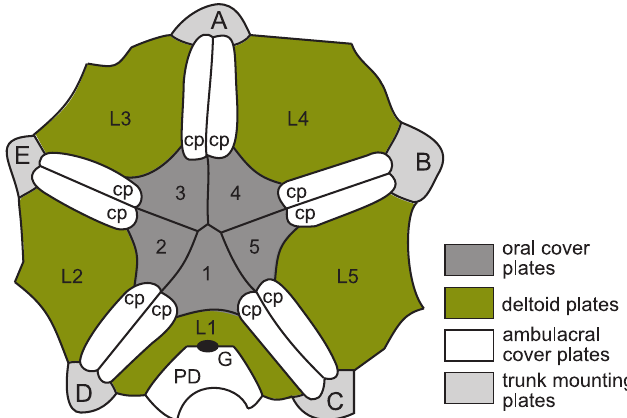
Fig. 24. Oral surface of the coronate Stephanocrinus angulatus Conrad, 1842, early Silurian (Wenlock), New York, USA, showing similarity to blastoid oral surface. Five erect ambulacra (A–E) arise from the trunk mounting plates, which are homologues of the lancets of blastoids. Food grooves are covered by paired ambulacral cover plates (cp). The mouth frame is composed of five homologues of blastoid deltoids and dichoporite lateral plates (L1–L5), and covered by primary oral cover plates (1–5). G, gonopore; PD, posterior deltoid. For plate homologies see Table 2. Redrawn and relabelled from Brett et al. 1983: 638, fig. 4A. homologous, which provides a link between the glyptocys- titoid rhombiferans on the one hand and blastoids, coronates and Lysocystites on the other. The oral frame of blastoids is composed of five deltoid plates, one in each interambula- crum (Fig. 23: D). The CD interambulacrum also contains the anus and at least one other deltoid. Coronates have an identical thecal plate arrangement to blastoids, including a mouth frame composed of five deltoids (Fig. 24: L1–L5). A second posterior deltoid lies aboral to deltoid L1 and shares the gonopore (Fig. 24: G). Both posterior deltoids are adoral to the anus.